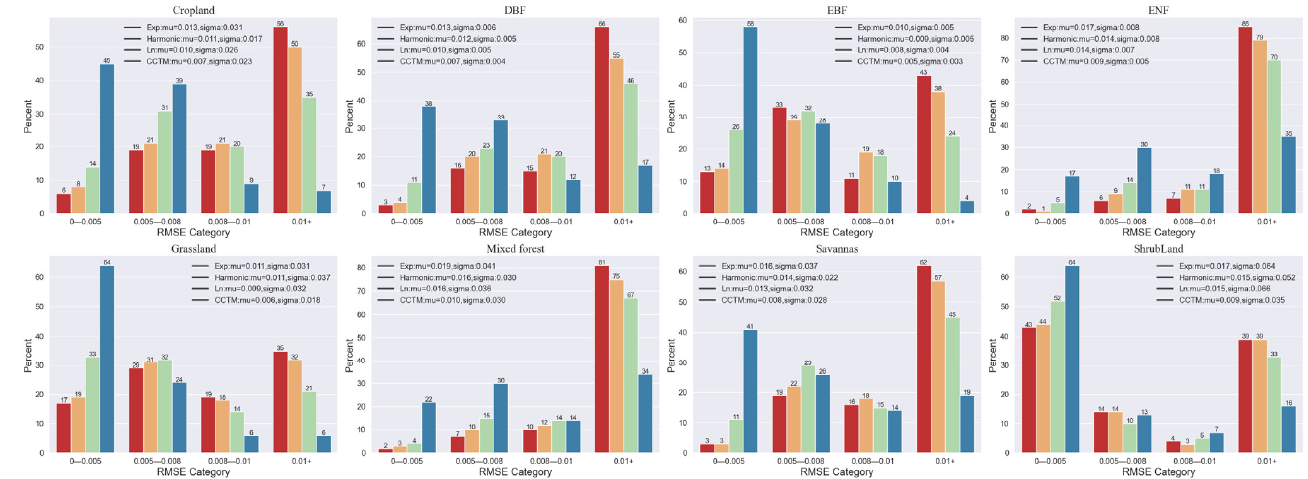
Figure 8. Reconstruction RMSE distribution of NDVI time series data with smoothing process. The frequency is the percentage of time series points in the certain RMSE range, and different landcover types may have different RMSE categories.